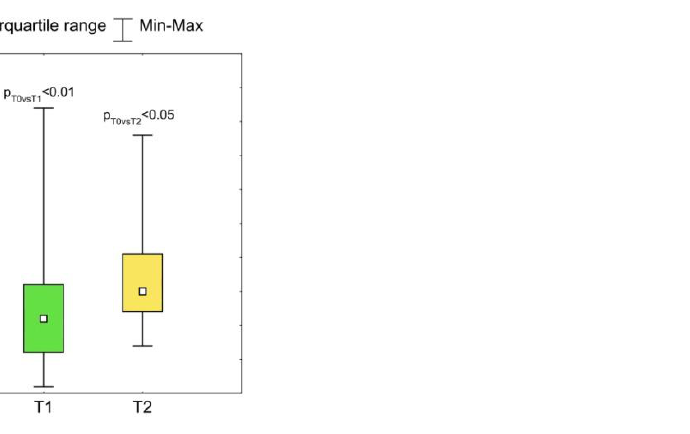
Figure 4. The hallux valgus (HV) angle before taping (T0), immediately after taping (T1) and after the removal of the tapes after a month of use (T2); p = statistical significance.